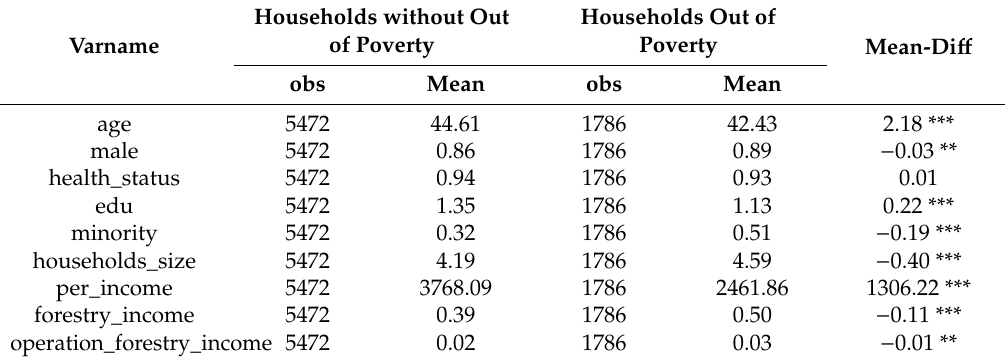
Table 8. Di ff erences in characteristics between households without out of poverty and out of poverty: mean t